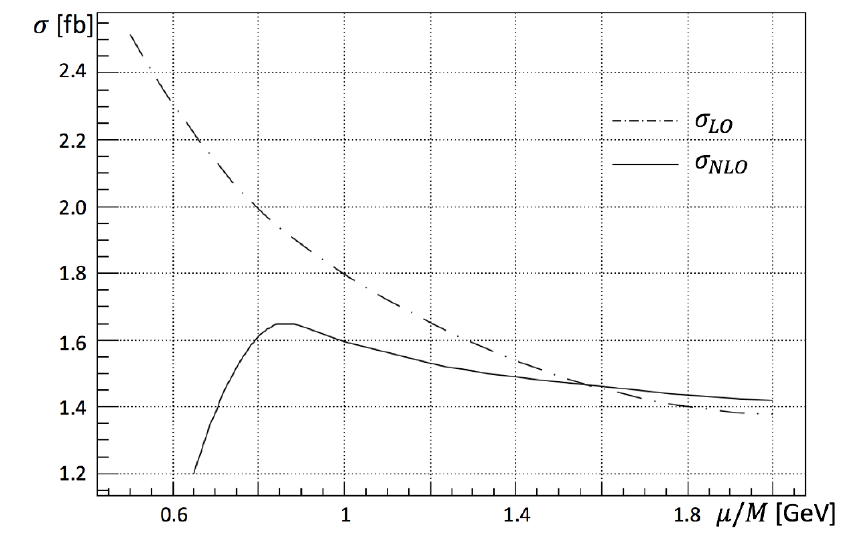
Figure 6 . Dependence of the total LO and NLO coloron pair production cross-sections on the combined renormalization and factorization scale (cid:22) = (cid:22) F . The plot is based on the pp center-of- p mass energy s = 14 TeV, mass M = 1 TeV, and mass splitting M (cid:0) M (cid:9) in the Born contribution as predicted by mUED, see text and eq. (4.1).